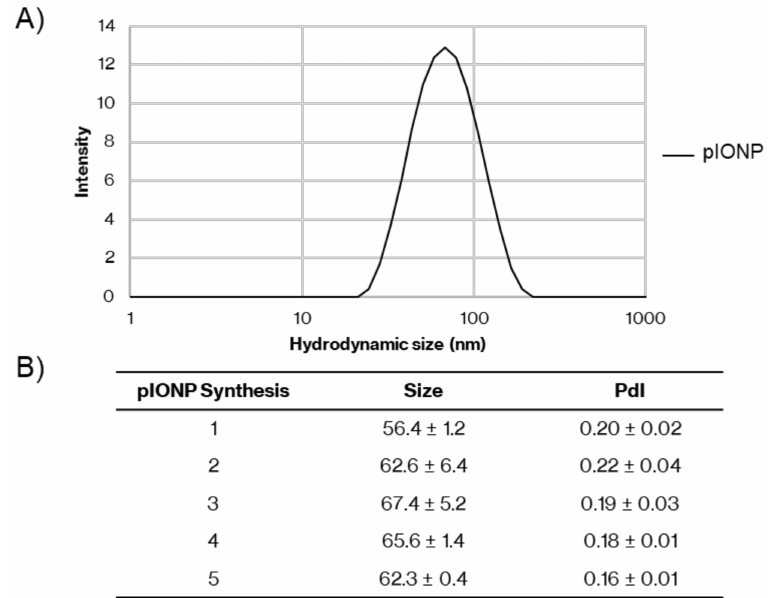
Figure 1. Size of di ff erent pullulan-coated iron oxide nanoparticle (pIONP) synthesis batches. Hydrodynamic size of pIONPs. ( A ) Representative plot of hydrodynamic size (intensity-based diameter) of pIONPs in saline, measured by dynamic light scattering (DLS). ( B ) Summary of replicates of particle synthesis with size and polydispersity index (PdI) measured by dynamic light scattering (DLS) in saline. In total, 1–3 independent measurements containing 2–3 cycles of repeated measurements were taken, with SD determined over all